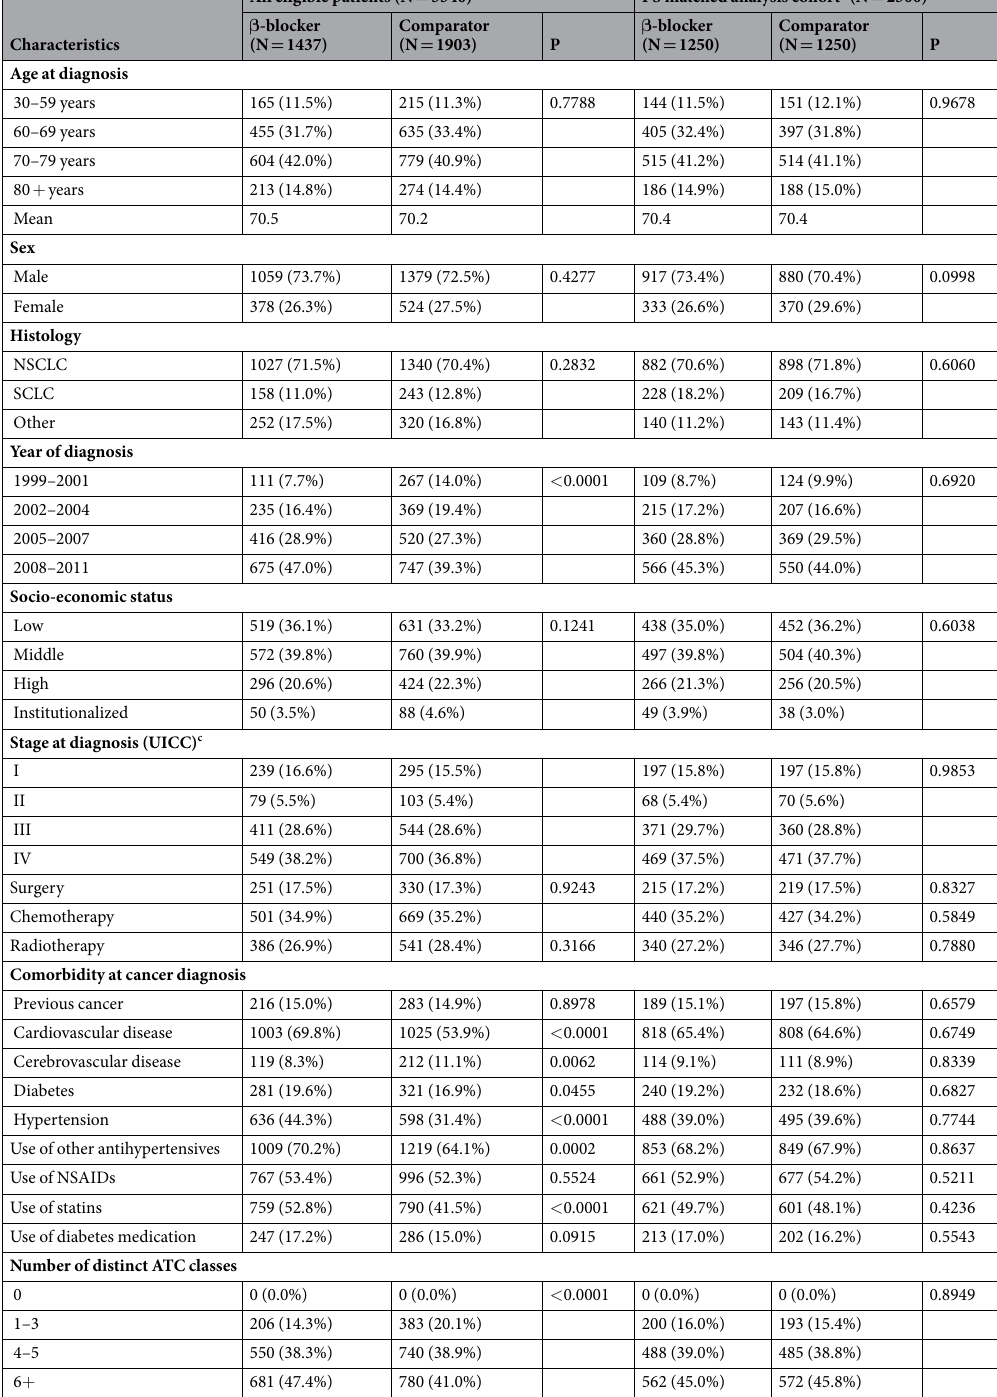
Table 1. Baseline Characteristics of Lung Cancer Patients by Pre-diagnostic β -blocker Intake a . Abbreviations: ATC = Anatomical Therapeutic Chemical Code, NSAIDs = Non-steroidal anti-inflammatory drugs, NSCLC = Non-small cell lung cancer, PS = Propensity score, SCLC = Small-cell lung cancer, UICC = Union Internationale Contre le Cancer. a Use of medications is defined as having at least one dispensing during four months prior to diagnosis. b Propensity scores (PS) were calculated using logistic regression. Individuals were matched using a 1:1 nearest neighbor matching algorithm with a caliper width of 0.2 standard deviations of PS logit and without replacement. c Stage was not applicable or determinable for 400 patients (non-matched cohort) and 297 patients (propensity score matched